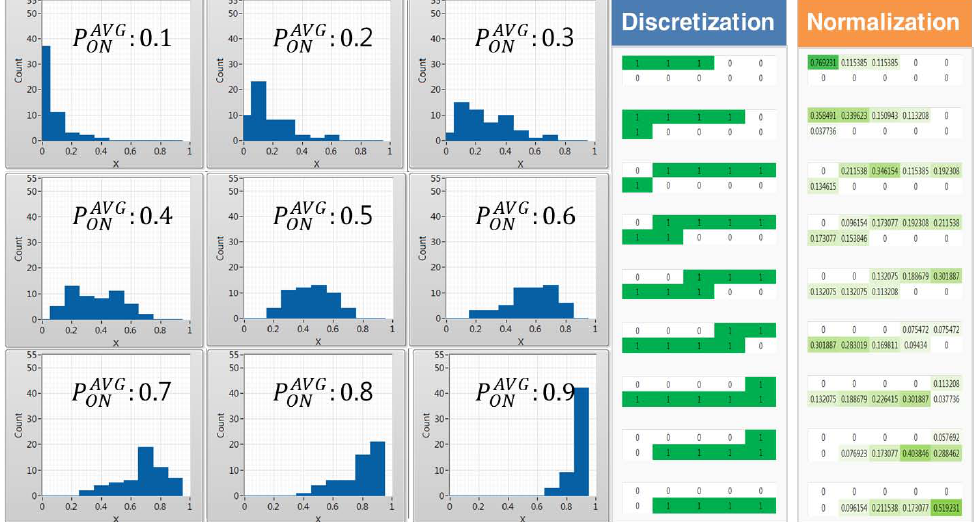
Figure 12. ( ∆ x = 10, L = 10) Histogram by average occupancy probability and pattern comparison by the data scaling